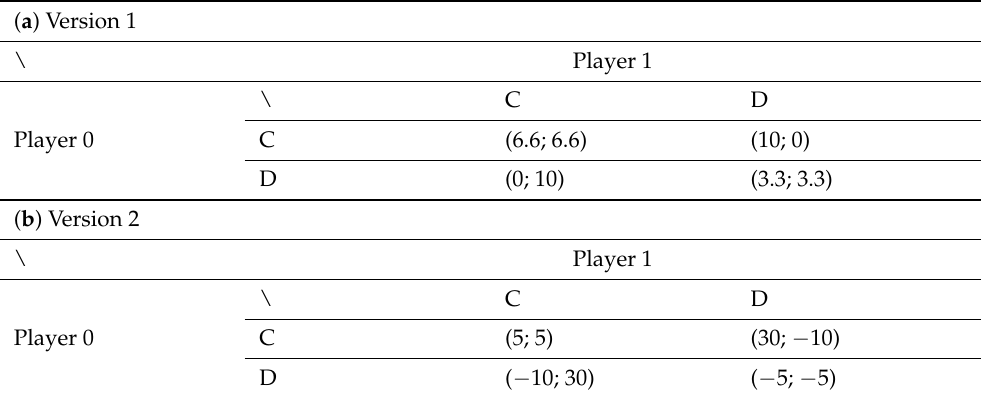
Table 3. Deadlock game payoff matrix representation (c > a > g > e and f > b > h >